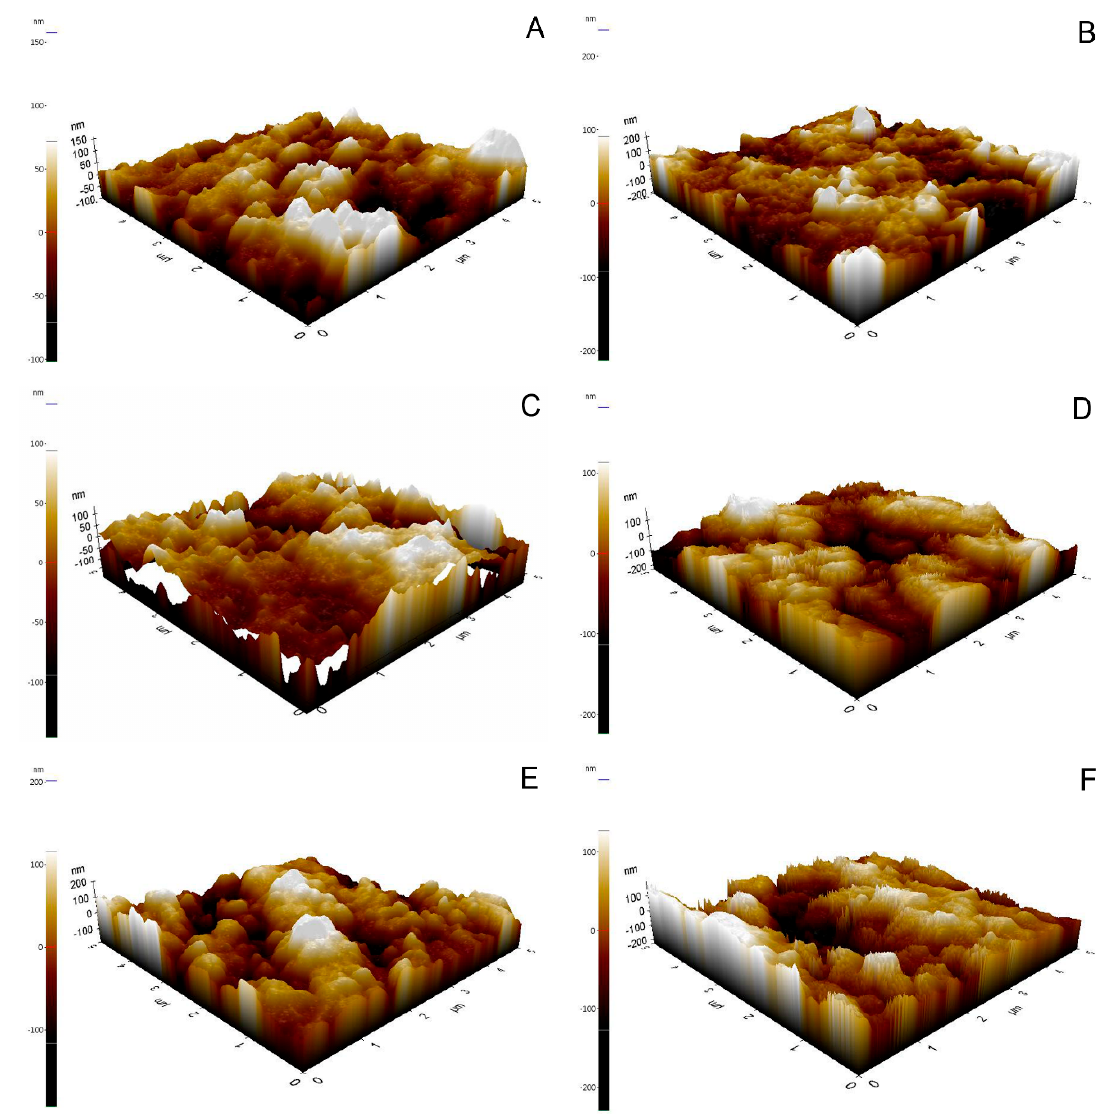
Figure 3. Scanning probe microscope images of the surface of each group after HF etching ( A ) 20HF1; ( B ) 20HF2; ( C ) 30HF1; ( D ) 30HF2; ( E ) 40HF1; ( F ) 40HF2.